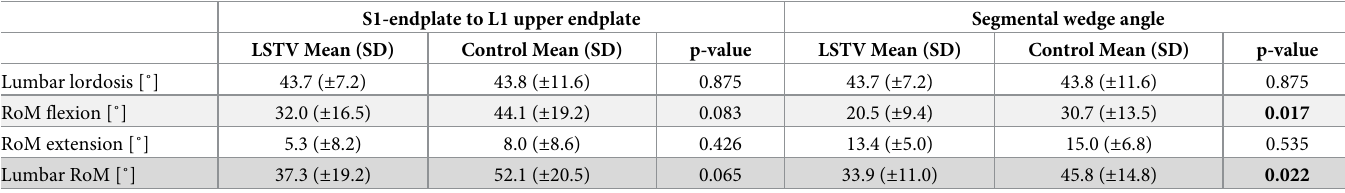
Table 2. Lumbar lordosis and range of motion in patients with LSTV and control